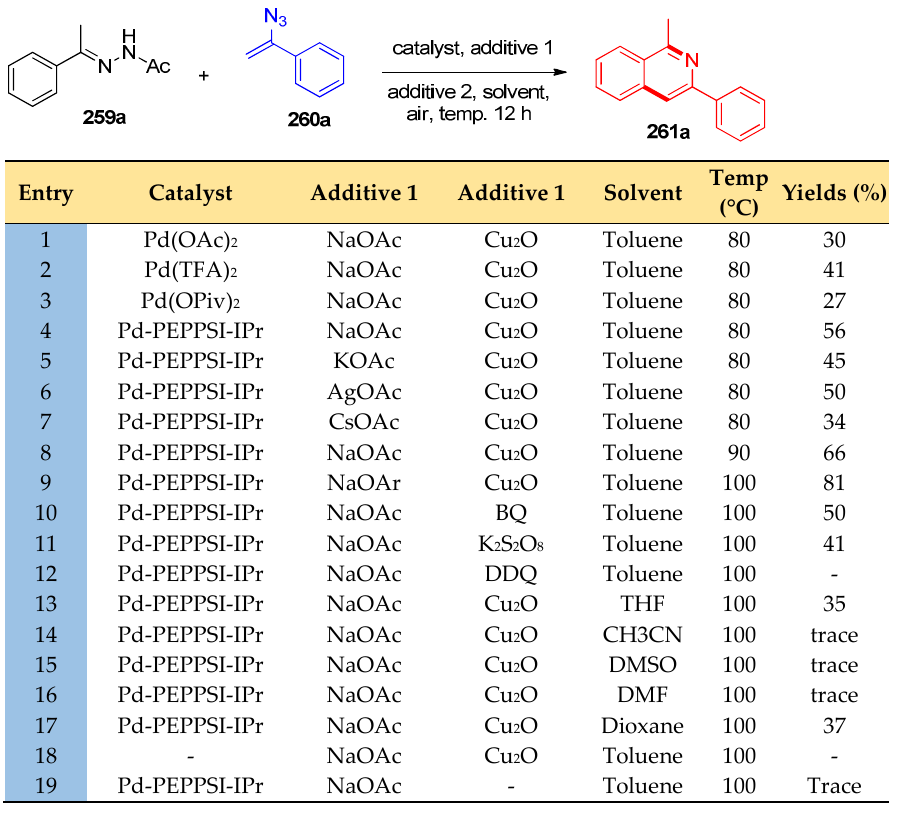
Scheme 101. Optimization of reaction conditions described the formation of 261a